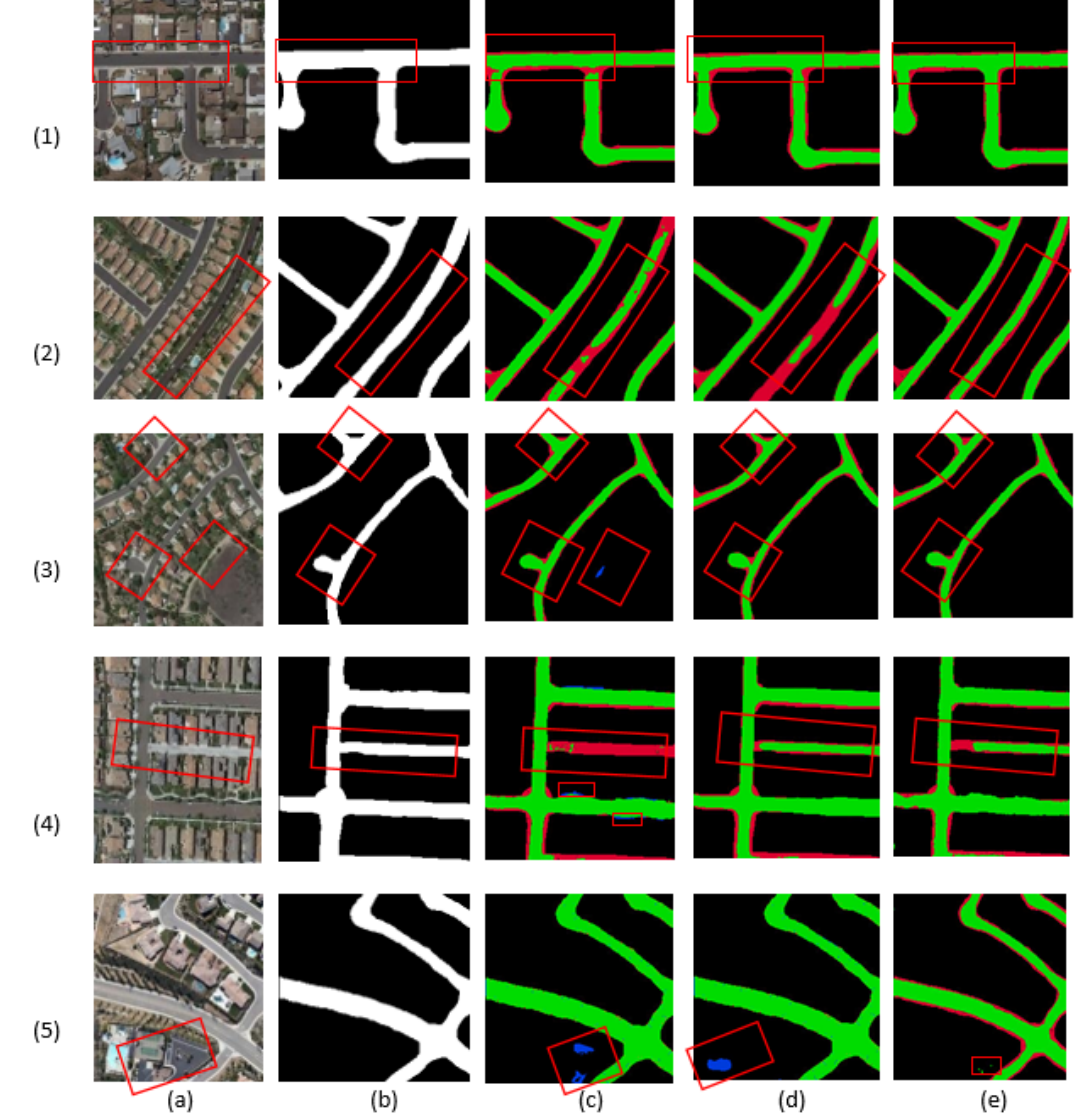
Figure 5. Comparisons among ( a ) the original images, ( b ) the ground truth images, ( c ) the predictions of Res-Unet, ( d ) the predictions of U-Net, and ( e ) the predictions of the proposed model. Green, red and blue represent TPs, FPs and FNs, respectively.